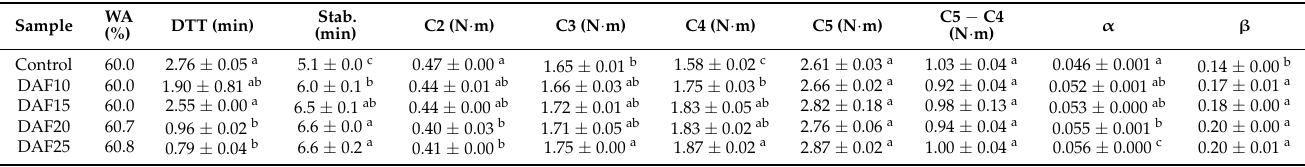
Table 3. Mixolab parameters of wheat flour with different substitution levels of acorn flour (C1:1.10 ± 0.05 Nm) a,b,c .